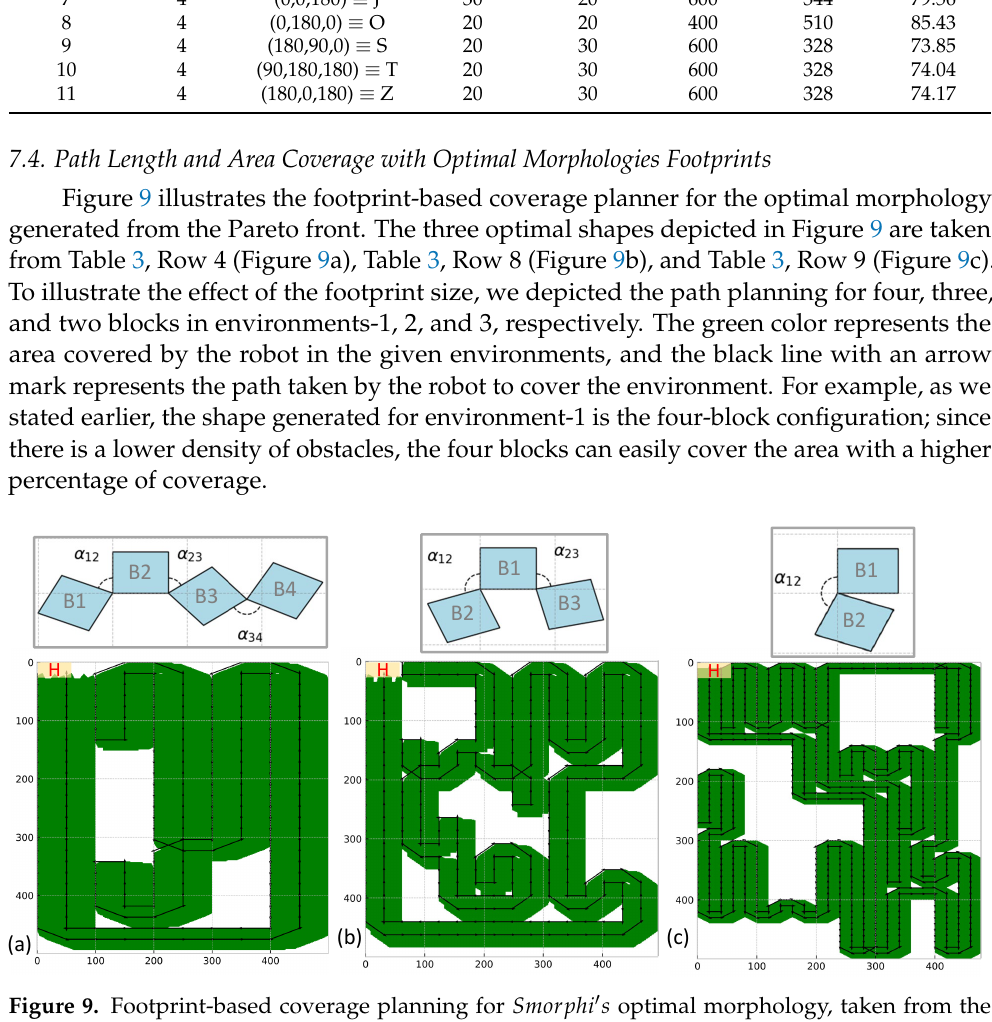
Figure 9. Footprint-based coverage planning for Smorphi (cid:48) s optimal morphology, taken from the Pareto front ( a ) Four blocks in environment-1, ( b ) Three blocks in environment-2, and ( c ) Two blocks in environment-3. (H—starting and goal